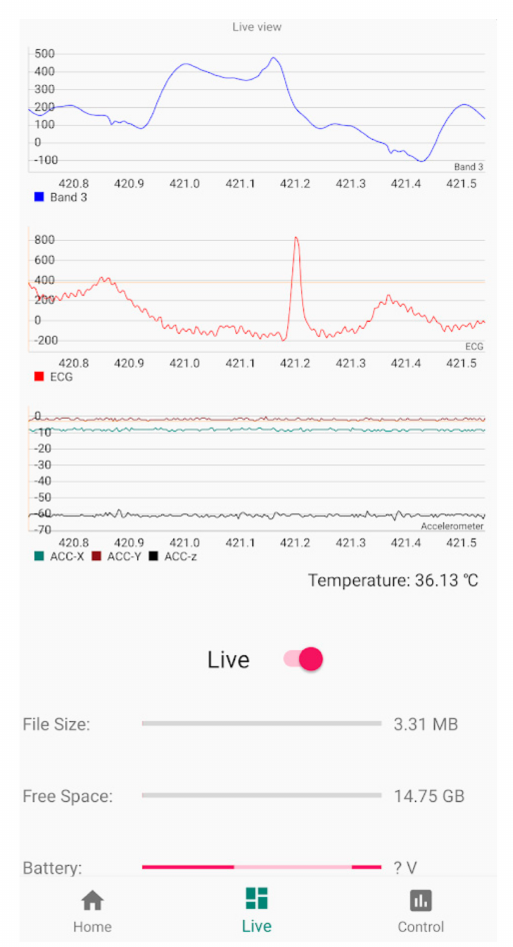
Figure 13. Screenshot (limited to one cardiac beat) taken from live Bluetooth streaming to Android 11 device including the proposed piezo based sensor as Band 3, ECG, X-Y-Z accelerometer data and body temperature from top to bottom. Please note that Y-axis units’ conversion in the prototype App have not been implemented